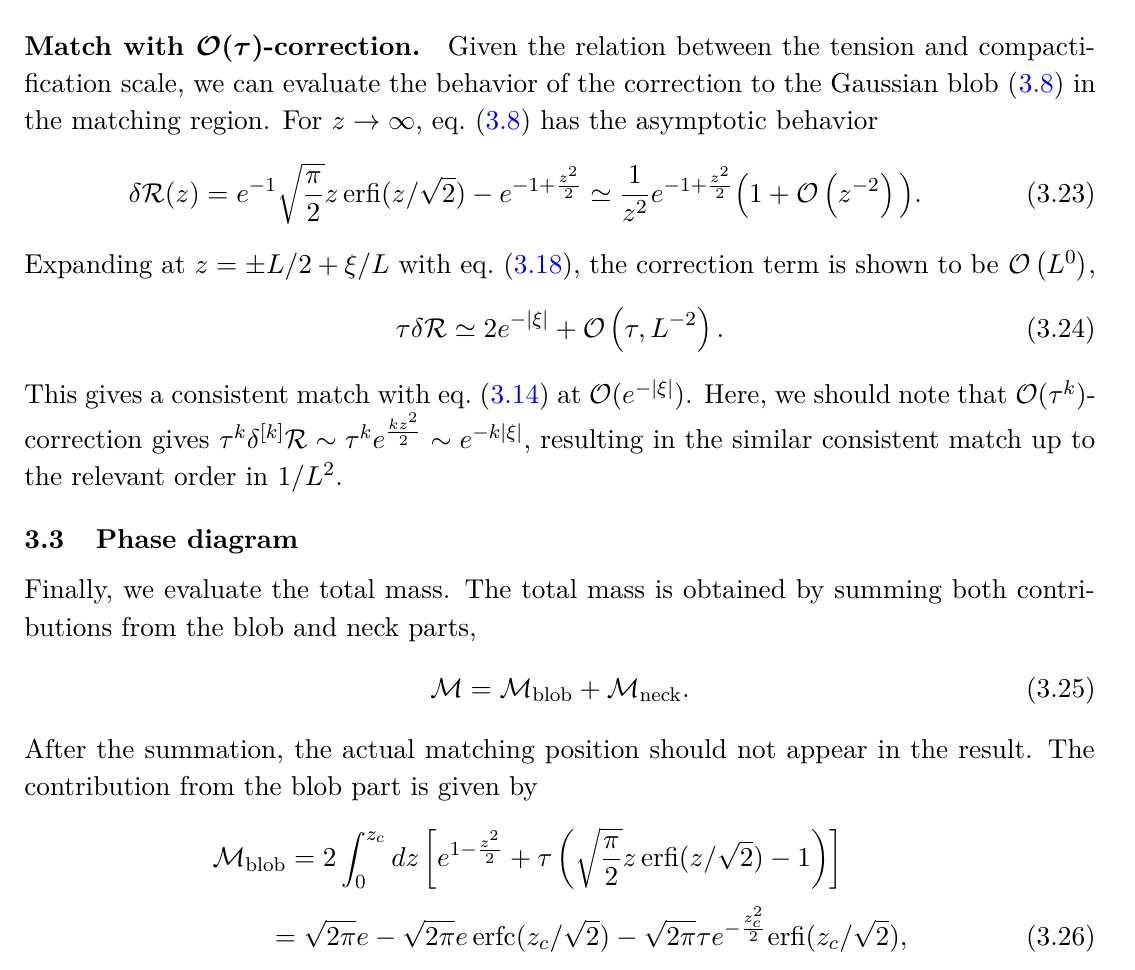
Figure 3 . The tension for given period L . The gray curve represents the numerical result. The red curve is given by the perturbative expansion in the small non-uniformity up to 8 -th order. The blue dotted, dashed and solid curves correspond the blob approximation up to LO, NLO and NNLO in eq. (3.22),